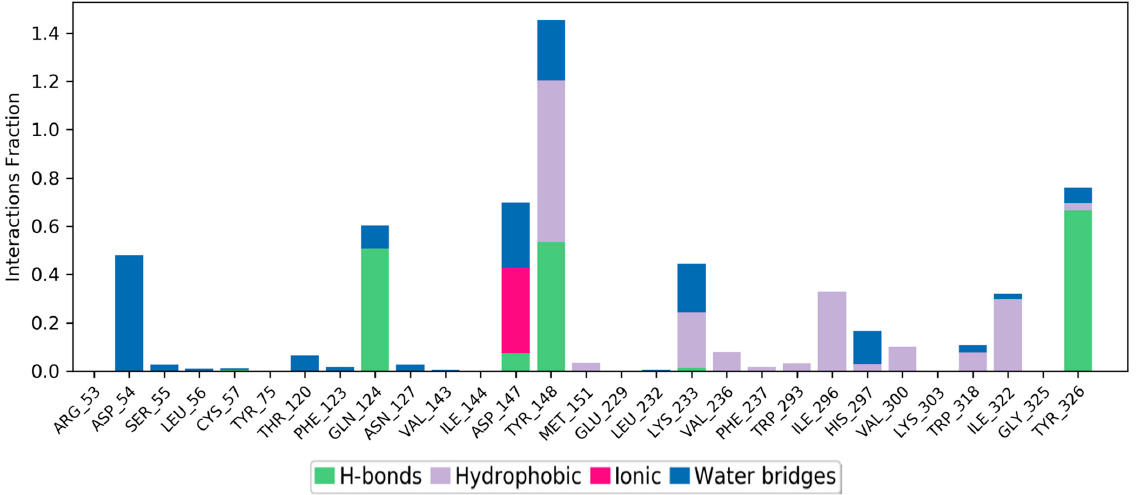
Figure 9. Simulation interaction diagram (SID) plot showing the protein–ligand interactions between the binding site and the MOR–M6 complex. Stacked bar charts include the fraction of occupancy among all of the MD simulation snapshots.